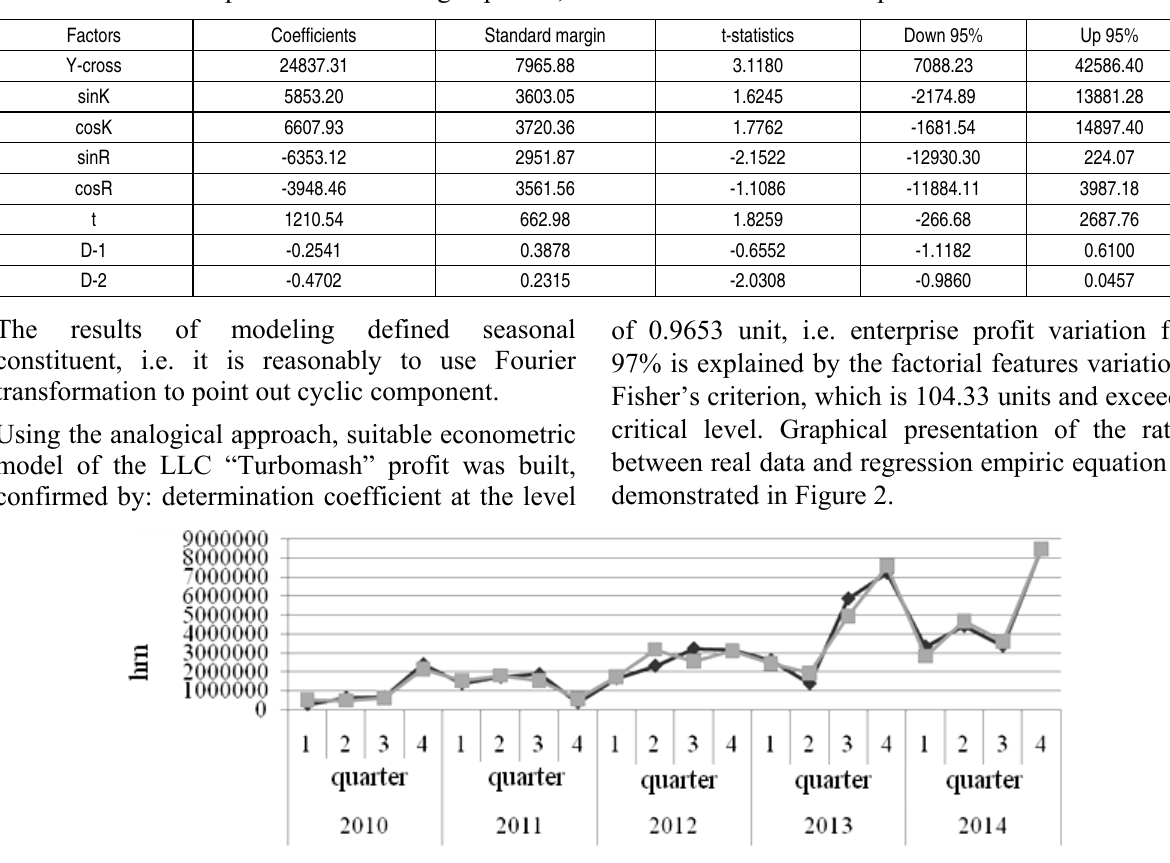
Table 1. Regressive statistics of research on demand depending for production from LLC “Turbomash” on profit and marketing expenses, time factor and demand for production